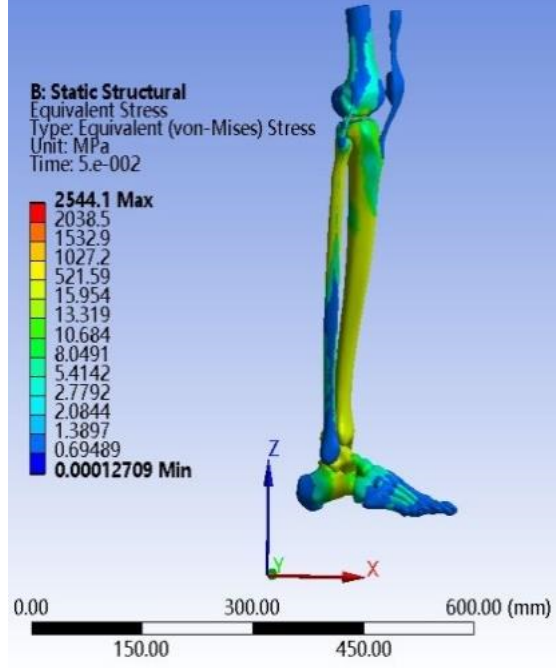
Fig. 5 The stress cloud surrounding the lower limbs of the human body at the moment of